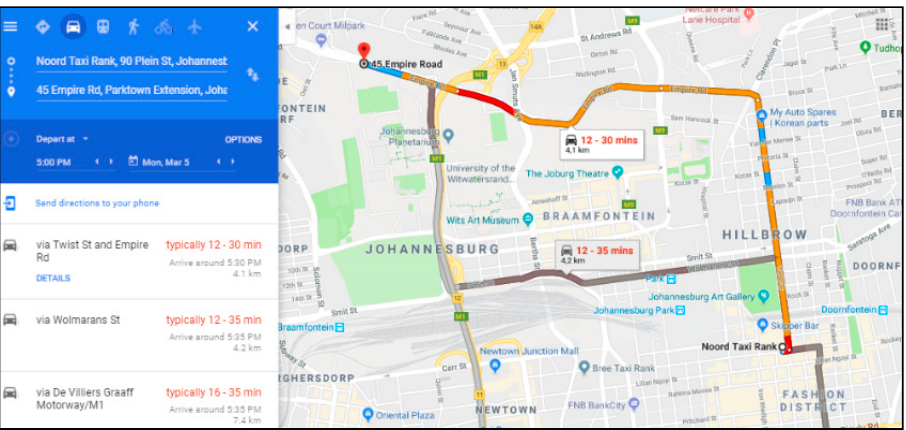
Figure 20. Traffic Data from Noord (suburb 1) Taxi Rank to Milpark (suburb 2) at 5:00 pm.